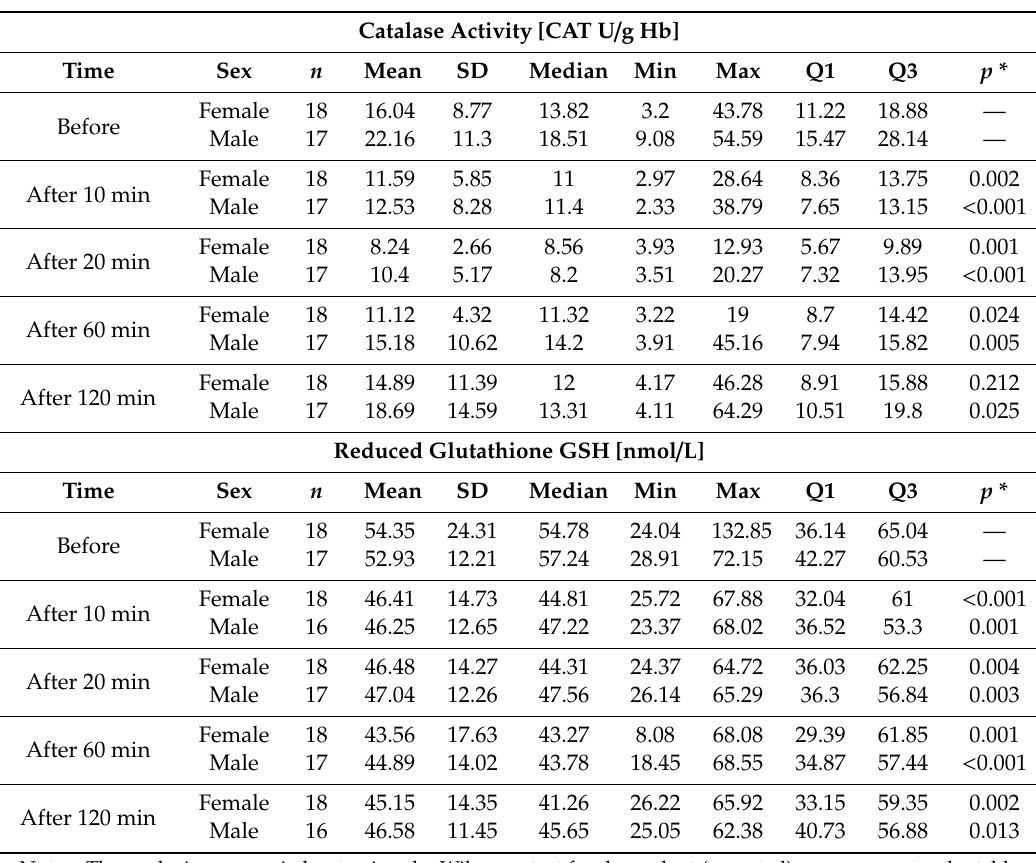
Table 2. CAT (catalase) activity [U / g Hb] in blood cells and GSH (glutathione) concentration [nmol / L] in plasma of subjects undergoing routine HRCT (high resolution computed tomography) before the examination, 10 min, 20 min, 60 min and 120 min after the